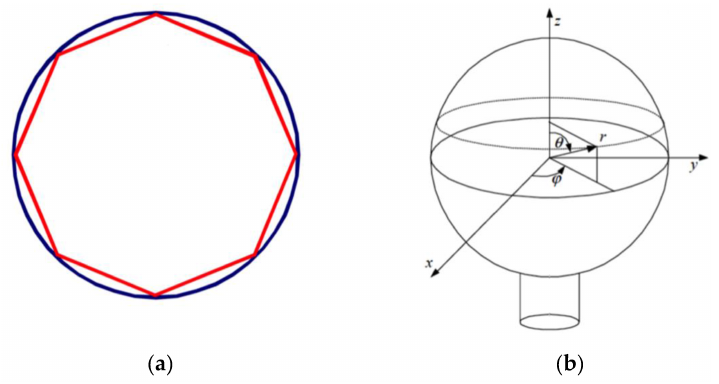
Figure 2. ( a ) WGM supported on the total internal reflection of an optical wave; ( b ) Spherical coordinates in a WGM spherical